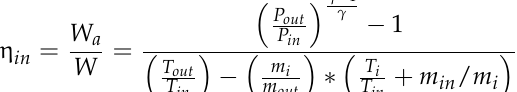
Figure 4. Comparison of computed and measured adiabatic efficiency characteristic.